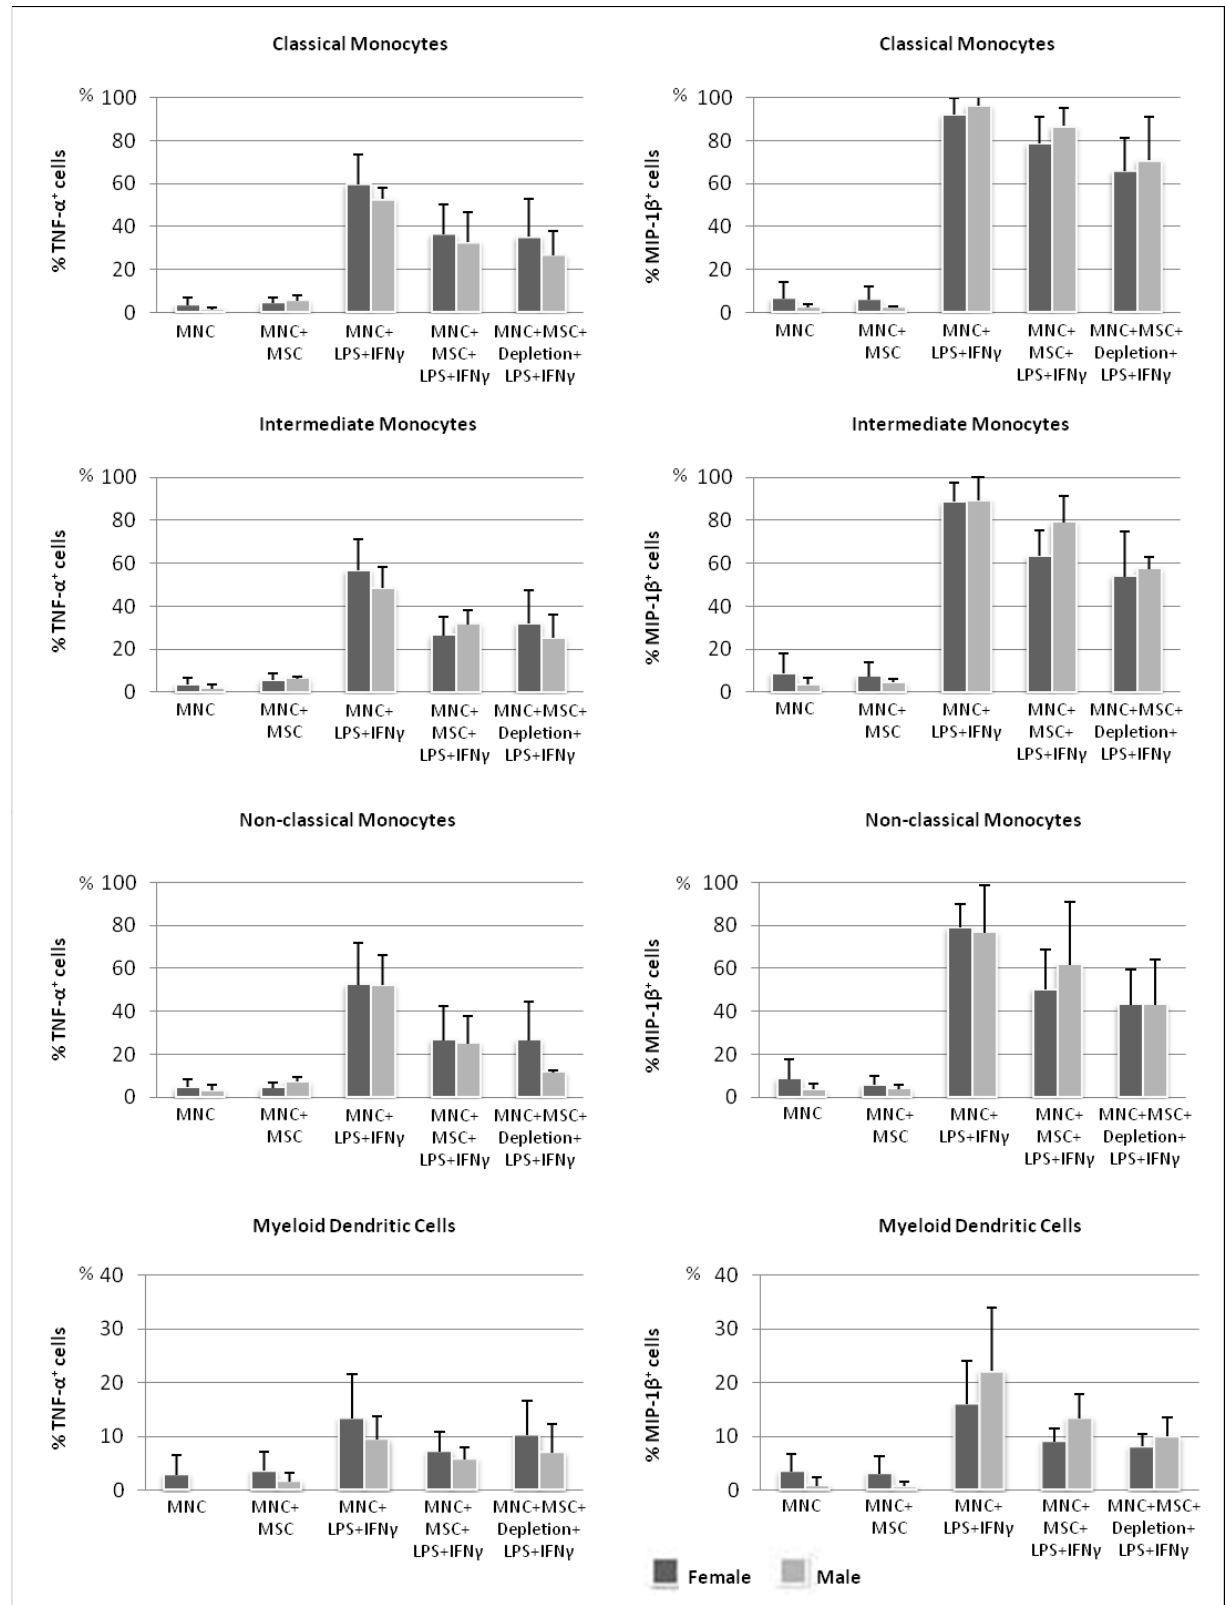
Figure A1. Comparison between male and female RA patients, concerning the protein production of TNF- α and MIP-1 β by monocytes and mDCs. Percentage (mean ± standard deviation) of mono- cyte subsets (classical, intermediate and non-classical) and mDCs, producing TNF- α and MIP-1 β ,